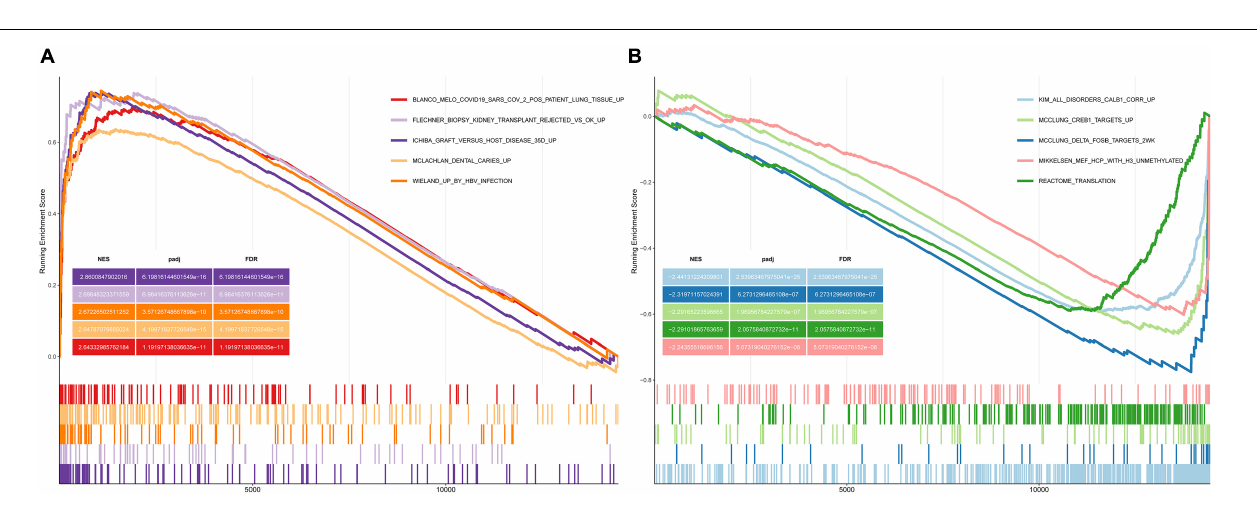
FIGURE 4 | Gene Set Enrichment Analysis plots showing the most enriched gene sets in C2 collection in severe presbycusis. (A) The top five most significant up-regulated enriched gene sets and (B) the top five most significant down-regulated enriched gene sets in GSE49543.